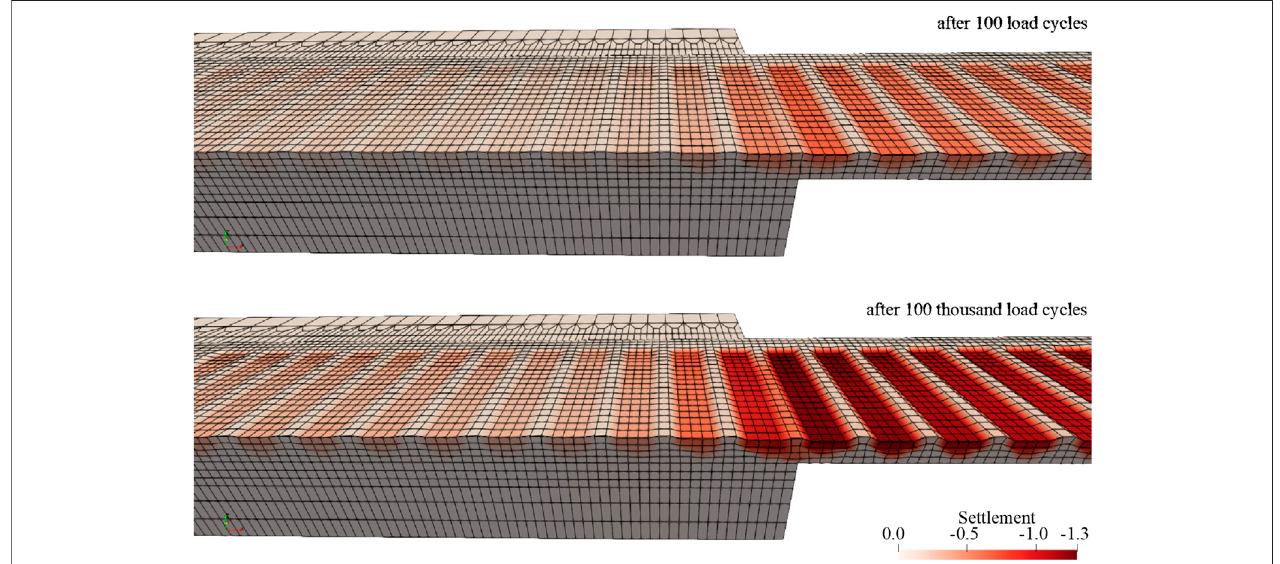
FIGURE 6 | 3D view of the deformed ballast-substructure system at N (cid:1) 100 and N (cid:1) 100 × 10 3 , ampli fi ed 20 times.